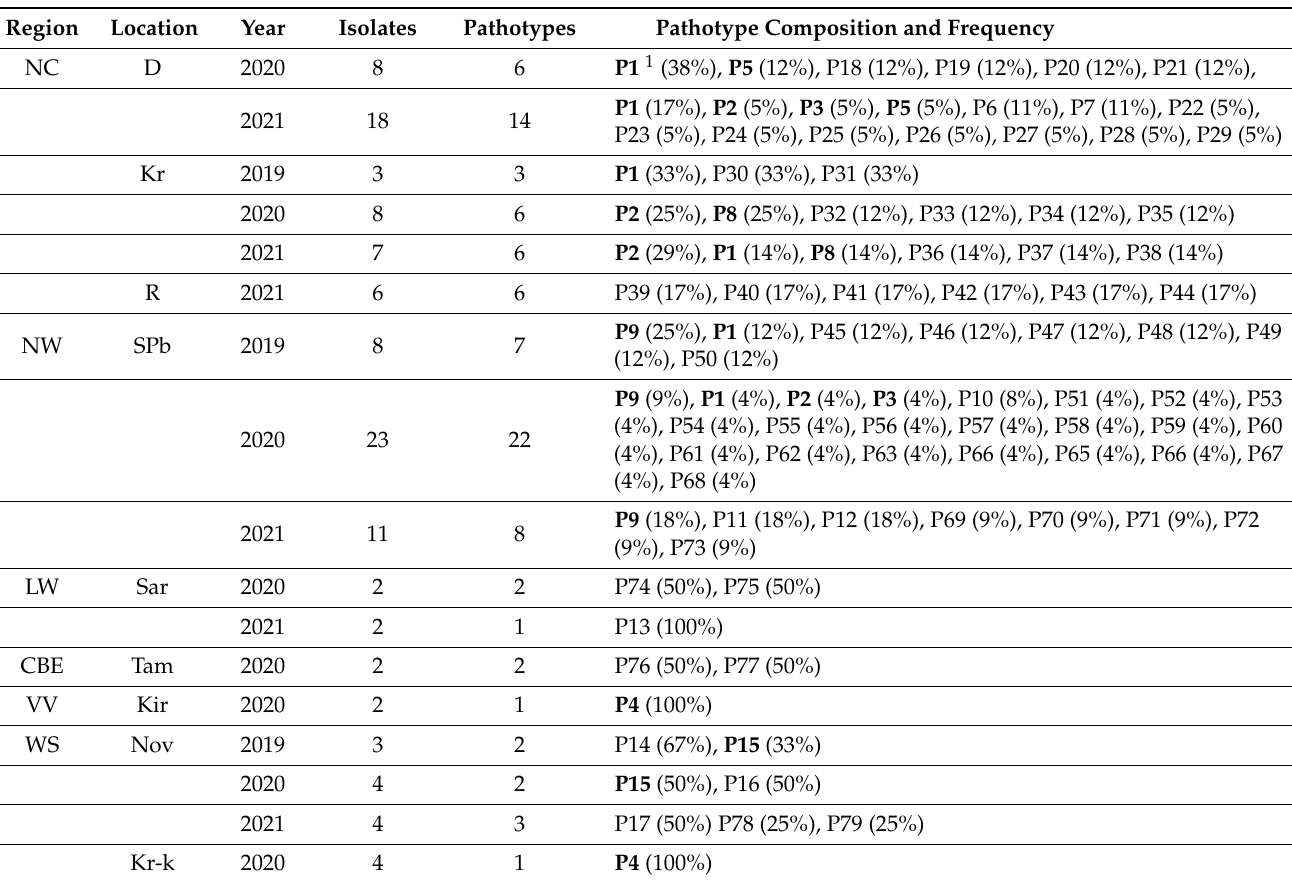
Table 3. Number of isolates and number of pathotypes of Puccinia striiformis identified and their frequencies in various locations in 2019–2021.